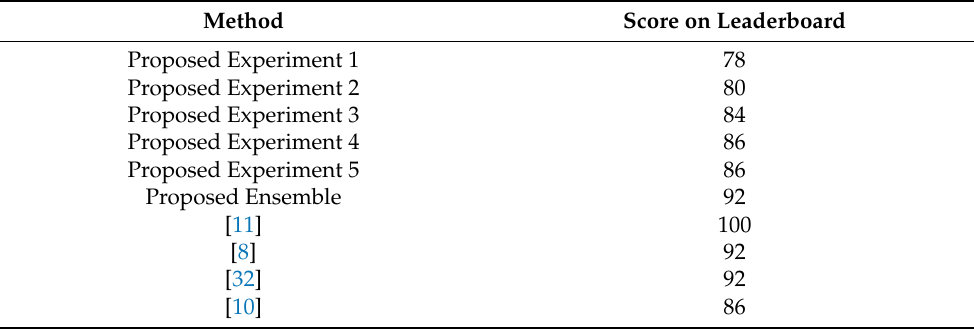
Table 7. Accuracy results of five ensemble few-shot classifications on the test leaderboard.